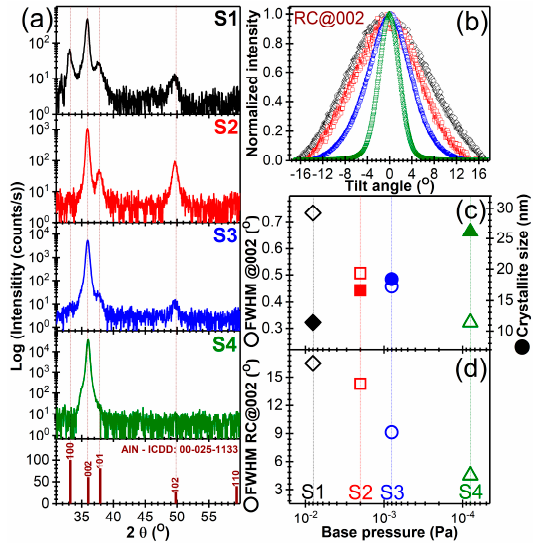
Figure 2. ( a ) X-Ray diffraction (XRD) diagrams (in logarithmic scale) of AlN films starting from different levels of base pressures (see Table 1). The ICDD reference file of hexagonal AlN is presented for comparison. ( b ) Comparative RCs recorded for the 002 reflections of AlN films. Evolution of the ( c ) FWHM of the 002 diffraction peaks (open symbols) and crystallite size along the c -axis (solid symbols) and ( d ) FWHM of the RCs of AlN (002) (open symbols).